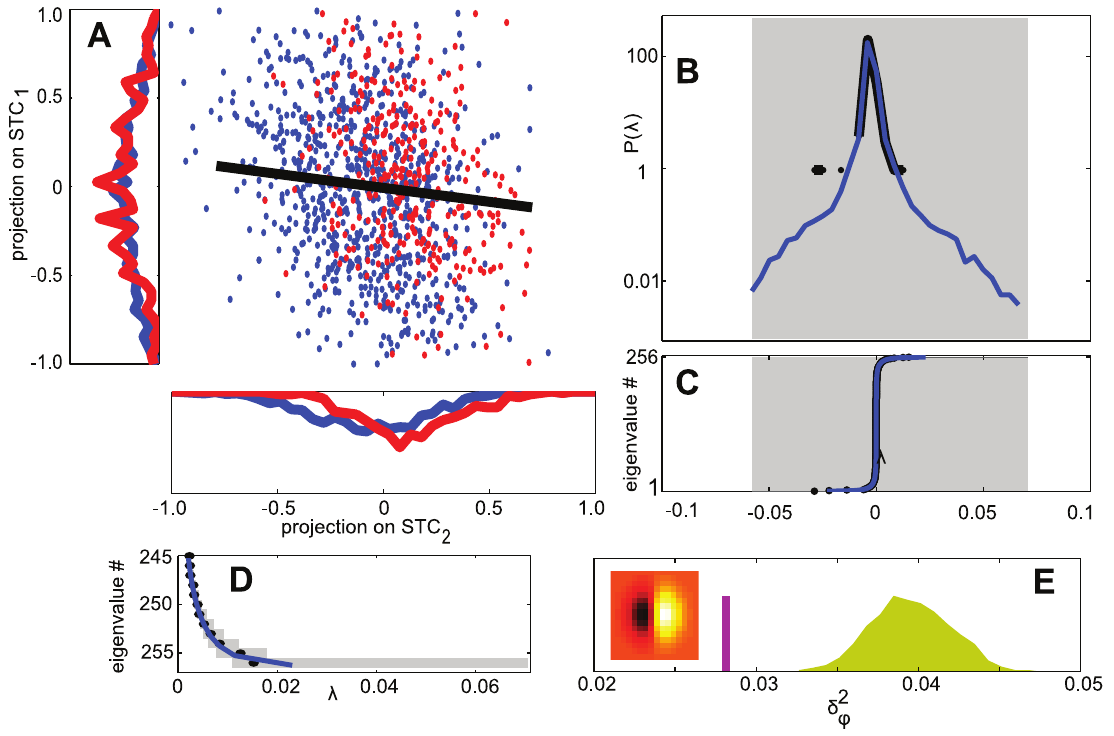
Figure 1. Spike triggered covariance analysis of simulated spike trains of a model with a single feature orthogonal to the coherent mode. (A) Inputs are plotted when projected on the eigenvectors corresponding to the largest eigenvalues of D C (in units of pixel illumination). Marginal distributions are plotted for each dimension. Inputs that elicited a spike are shown in red, and those that did not in blue. By construction, the change in variance is larger along the first dimension. (B) The empirical eigenvalue distribution of D C (black) compared to the null distribution (blue). No eigenvalues of D C are found to be significant (shaded area indicates 98 % confidence intervals for the support of the null distribution) (C) Rank ordered eigenvalues (black) plotted with the null distribution (blue). (D) Nested rank-wise significance testing. The highest ranked eigenvalues of D C are within the 98 % confidence intervals derived from the null distribution constructed for each rank separately (see Materials and Methods for , the variance of the projection of the spike-triggered stimulus on the relevant feature w details). (E) For each random spike train we computed d 2 w for the real spike train, suggesting the spike train contains enough signal to determine the (distribution shown in yellow). The purple line indicates d 2 w relevant feature as significant. Inset shows the relevant feature, a 16 | 16 image patch ( p ~ 256 ). Simulation details: N ~ 1189 , N spike ~ 329 , 250 repetitions to find D C null .